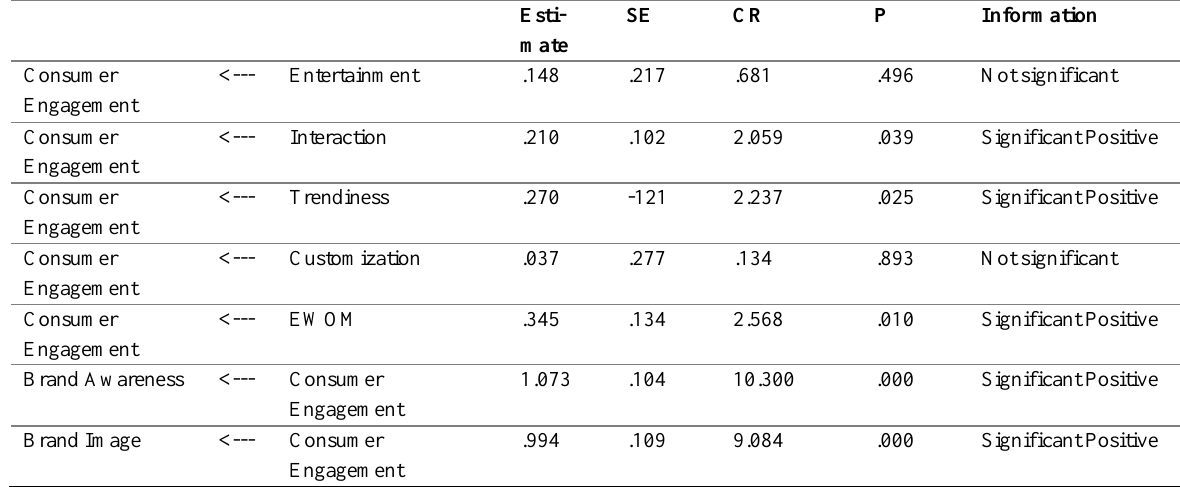
Table 3: Regression weight test